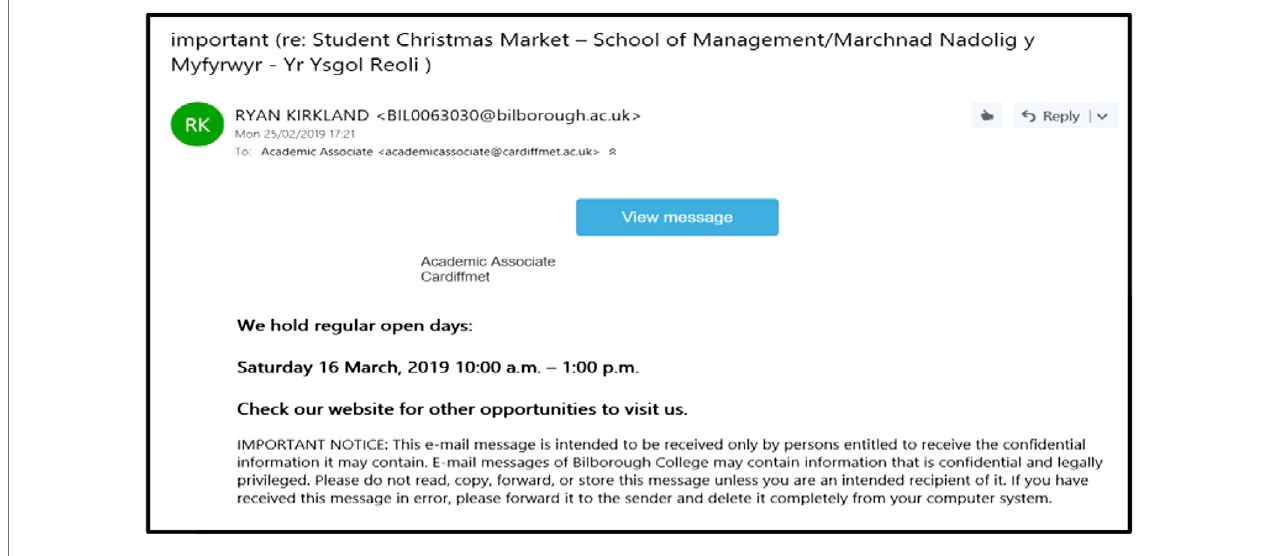
FIGURE 2 | Screenshot of a real suspicious phishing email received by the authors ’ institution in February 2019.